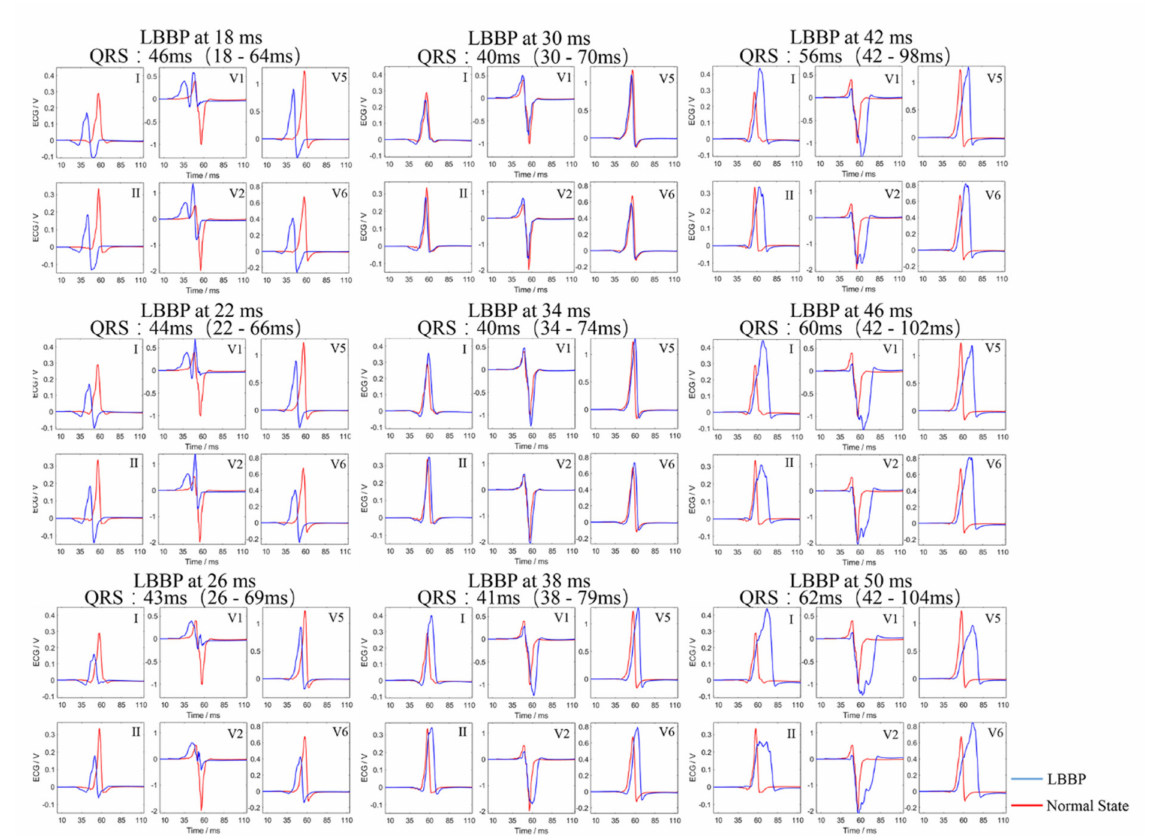
Figure 5. The QRS complex and duration of the synthetic ECG (blue line) under LBBP correcting LBBB at nine different moments spaced 4 ms apart. The synthetic ECG results in the normal state were referenced (red line). LBBP: left bundle branch pacing. LBBB: left bundle branch